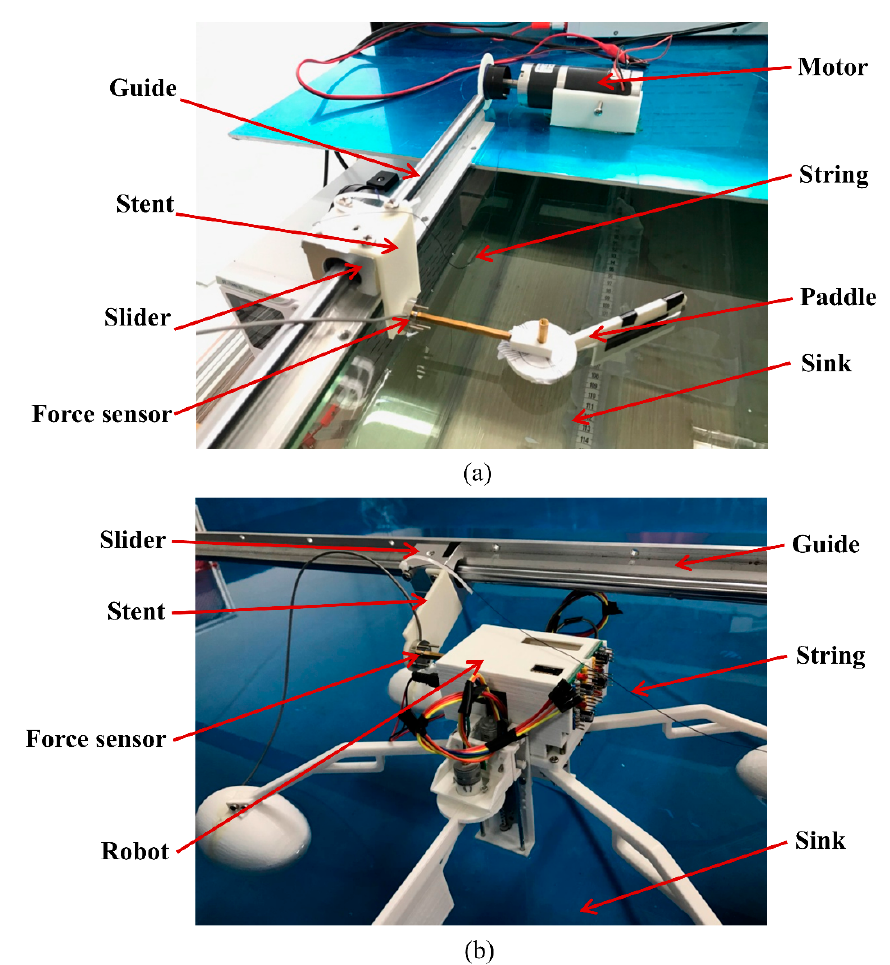
Figure 8. Pictures of the parameter measurement experiment: ( a ) K T measurement experiment; ( b ) K D measurement experiment.